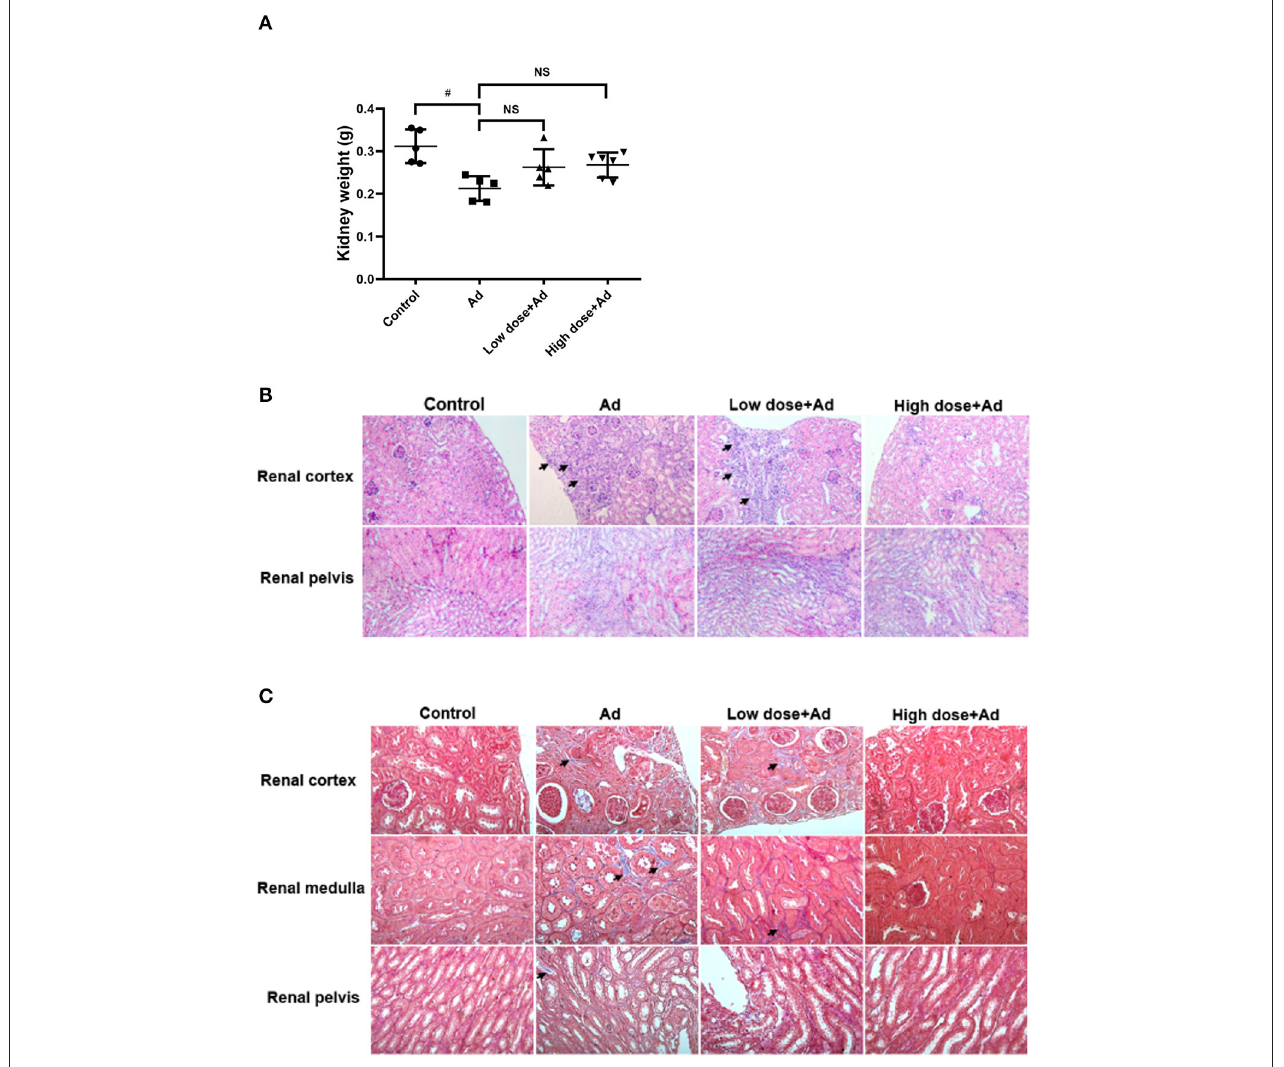
FIGURE 3 | Gross examination and histological analysis of kidneys in mice with adenine (Ad)-induced chronic kidney disease (CKD), with or without probiotic administration. The kidneys of mice were collected and weighed. Histological sections of the renal cortex, renal medulla, and renal pelvis in Ad-induced CKD mice with or without probiotic treatment were studied. (A) Weights of the kidneys, (B) hematoxylin and eosin (H&E)-stained kidney sections, and (C) Masson’s trichrome (MT)-stained kidney sections. The graphs represent mean ± SD obtained from five to six mice per group. Statistical analysis was performed by Kruskal–Wallis test ( # P < 0.05; NS, not significant). The arrows in (B) and (C) indicate infiltration of inflammatory cells and tissue fibrosis, respectively. Mice without any treatment served as the experimental control (Magnification for H&E stain, 200 × ; magnification for MT stain, 400 × ).